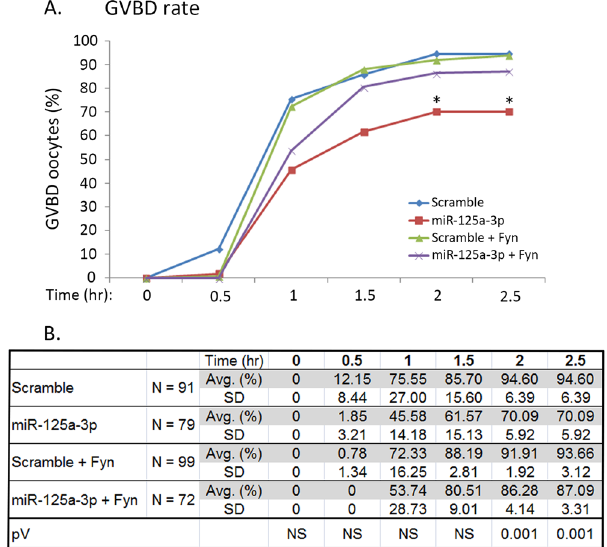
Figure 2. Over-expression of miR-125a-3p inhibits the rate of GVBD in a Fyn-dependent manner. GV oocytes were microinjected with either miR-125a-3p mimic (miR-125a-3p) or scramble-miR (Scramble), both either with or without Fyn RNA that lacks the 3 ′ UTR region (miR-125a-3p + Fyn or, Scramble + Fyn). Oocytes were incubated for 4 hours at 37 °C in the presence of 1 µ M milrinone, washed and transferred to fresh milrinone- free culture medium. Oocytes were monitored for GVBD every 30 minutes for 2.5 hours. The experiment was repeated three times. Results were analyzed by repeated measures ANOVA followed by Tukey post hoc test, and are presented in a line-chart, * p < 0.05 ( A ). The table ( B ) indicates the average of percent GVBD oocytes and SD of each dot presented at the